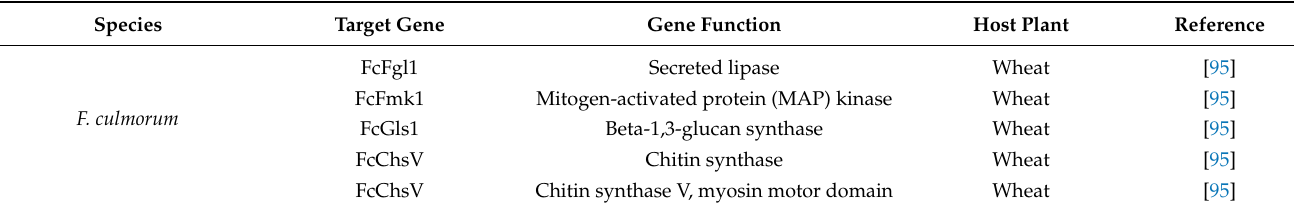
Table 2. Fusarium pathogenicity genes according to Rampersad, 2020